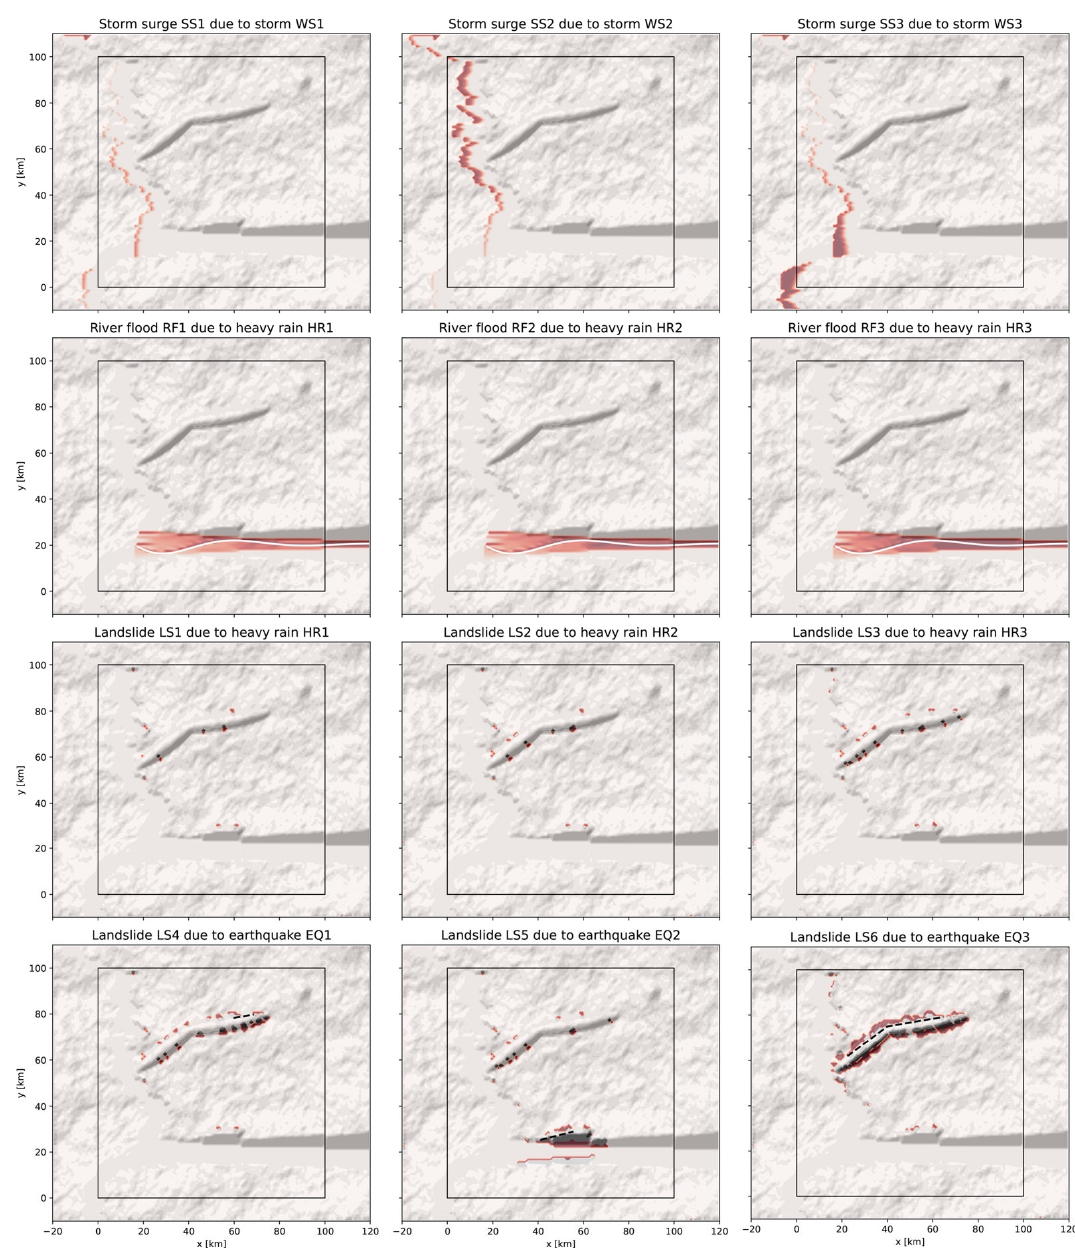
Figure 8. Examples of intensity footprints for secondary perils, based on a simple threshold model for storm surge (Section 2.2.2) and on cellular automata for landslides and river floods (Section 2.2.3). All the footprints here depend on the topography z ( x , y ) and/or soil h ( x , y ) environmental layers. The color scale saturates at intensities of 3 m for storm surges, 50 cm for river floods, and 1 m for landslides. The white curves represent the river and the black dashed lines the earthquake segments that trigger the